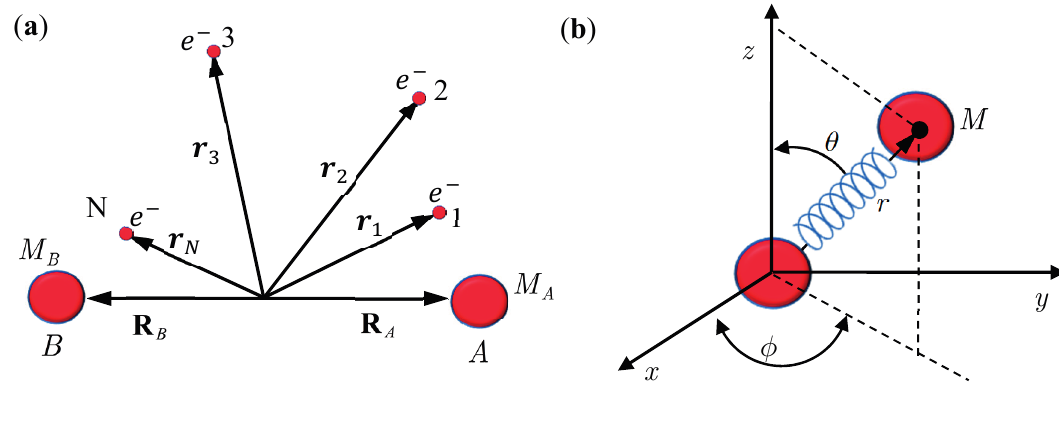
Figure 1. ( a ) A diatomic molecule composed of Nuclei A and B, together with a number of electrons; ( b ) An equivalent single-particle model of the diatomic molecule with rotation and vibration motion described by the spherical